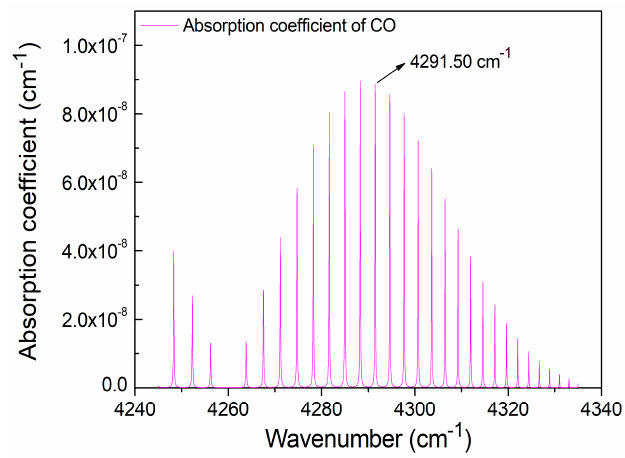
Figure 3. Absorption lines for CO molecules in the 2.3 μ m first overtone absorption band based on the HITRAN 2012 database.